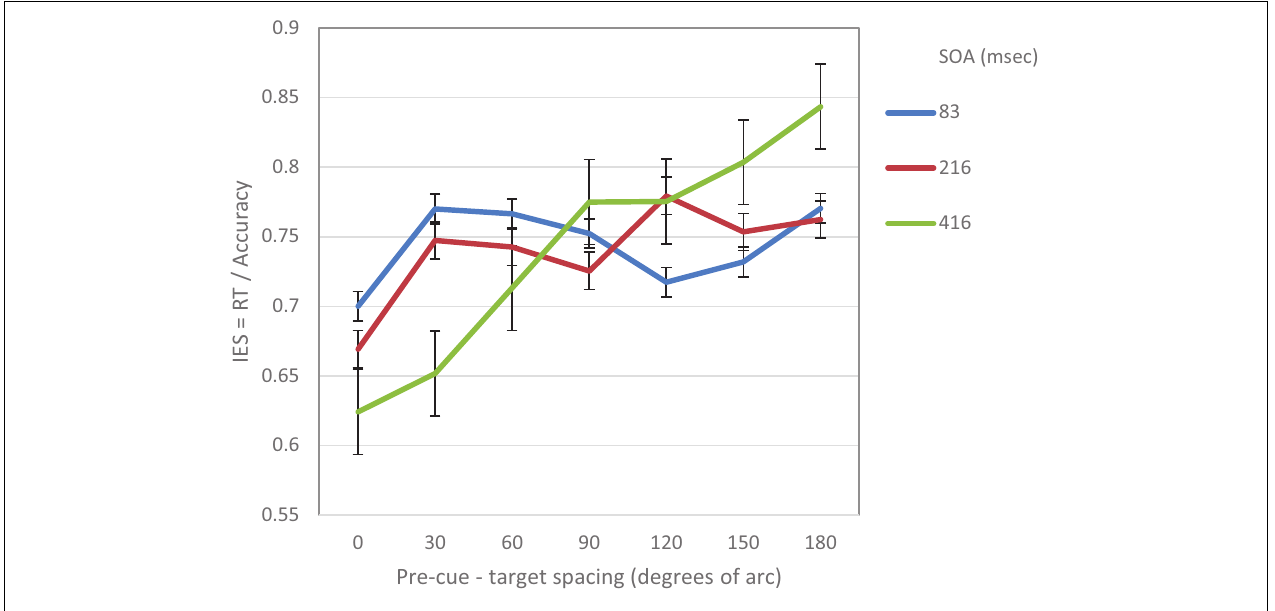
FIGURE 3 | IES curves in Experiment 2 as a function of pre-cue – target spacing and SOA.